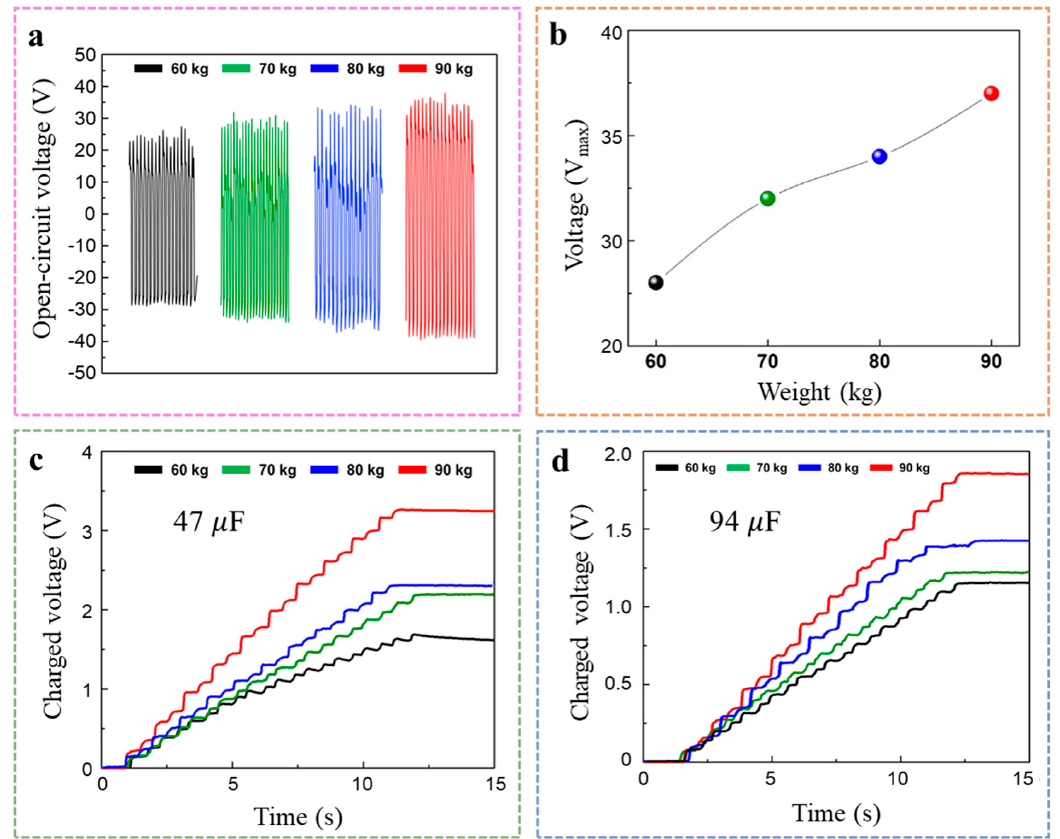
Figure 6. ( a ) Open-circuit voltage waveform and ( b ) Maximum voltage according to the weight of the object, ( c ) Charged voltage with a capacitor with 47 μF and ( d ) With 94 μF .